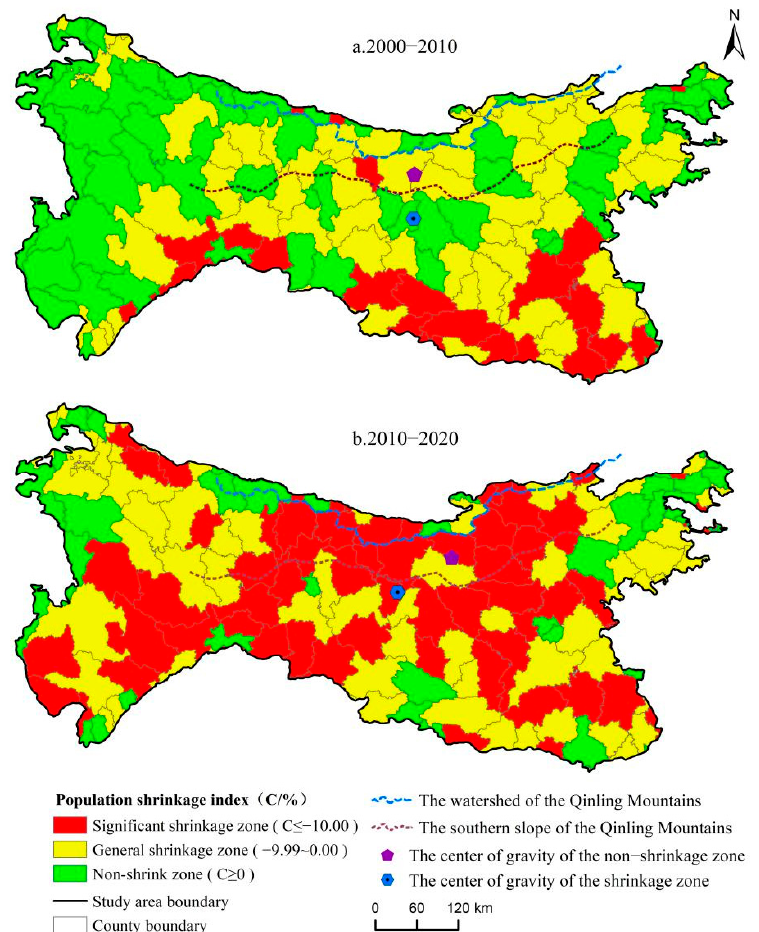
Figure 2. County population shrinkage patterns in North–South Transitional Zone of China ( a , b )